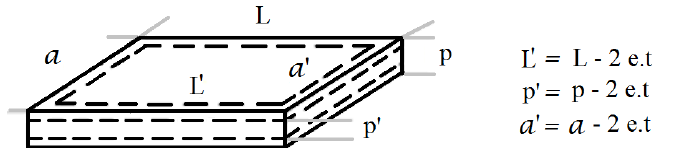
Figure 1. Theoretical representation of corrosion rate of a sheet by the reaction of aluminum–water. The active surface of the sheet as a function of the initial aluminum mass W Al ,0 , purity η and density ρ is described by Equation